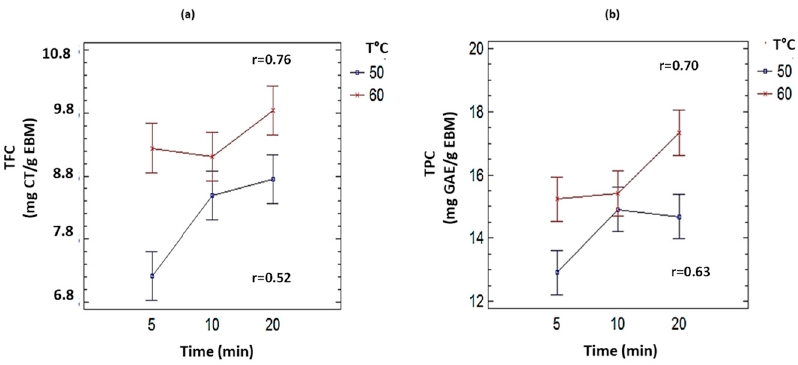
Figure 2. Relationship of temperature and time factors at different levels on ( a ) total flavonoids con- tent (TFC) and ( b ) total polyphenol content (TPC). (r = Pearson coefficient of correlation). ( p < 0.005).